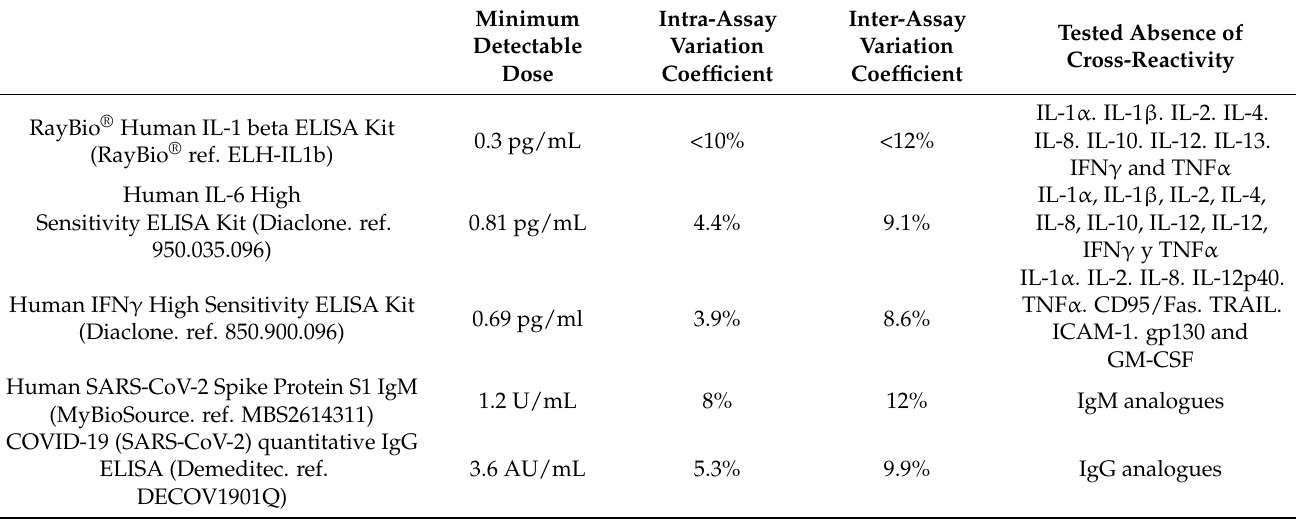
Table 1. Main properties of the